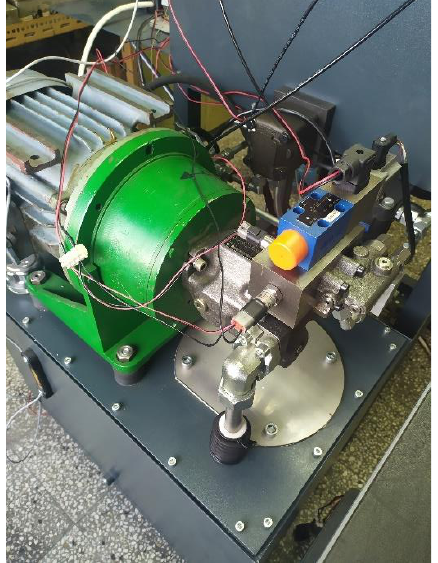
Figure 2. Photo of the test rig.